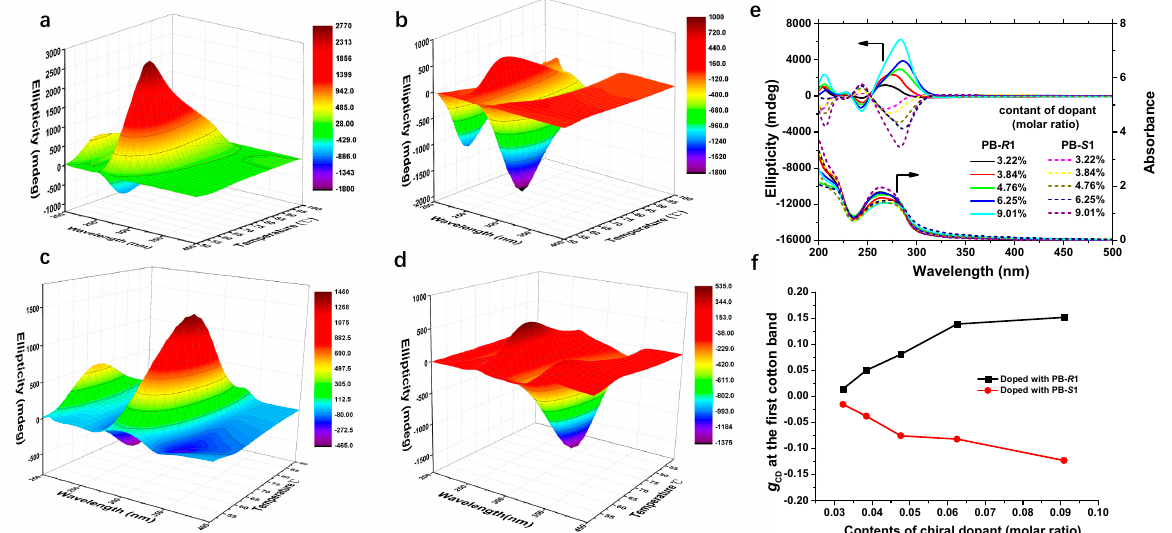
Figure 3. ( a – d ) CD spectra of the chiral induction of different polymer films during the heating process. ( a ) PPBMA 3 film doped with PB- R 1. ( b ) PPBMA 3 film doped with PB- S 1. ( c ) PCNBMA 3 doped with CNB- R 1. ( d ) PCNBMA 3 doped with CNB- S 1. ( e ) CD and UV-vis spectra of PPBMA 3 doped with different content of PB- R 1 and PB- S 1. ( f ) g CD values of PPBMA 3 doped with different content of PB- R 1 and PB- S 1, calculated from ( e ).